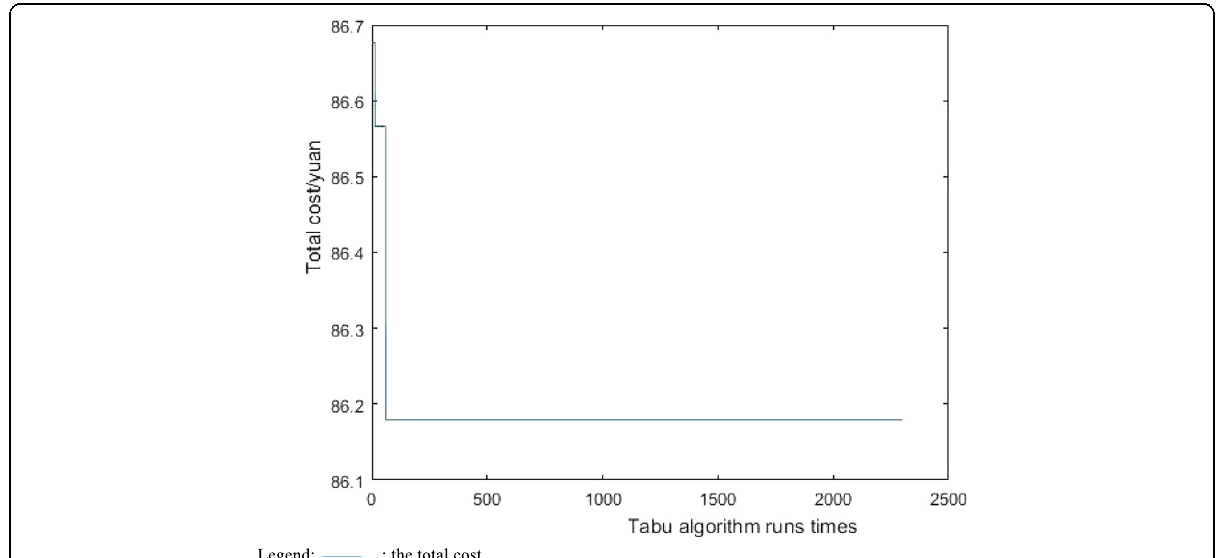
Fig. 5 When the tabu search algorithm was secondly used. Route 1 total cost variation. The blue line represents the total